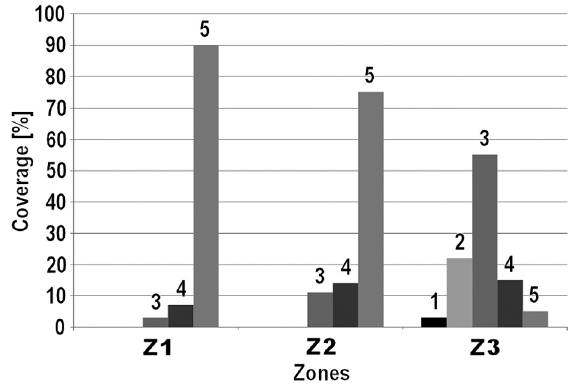
Fig. 3. Vertical vegetation